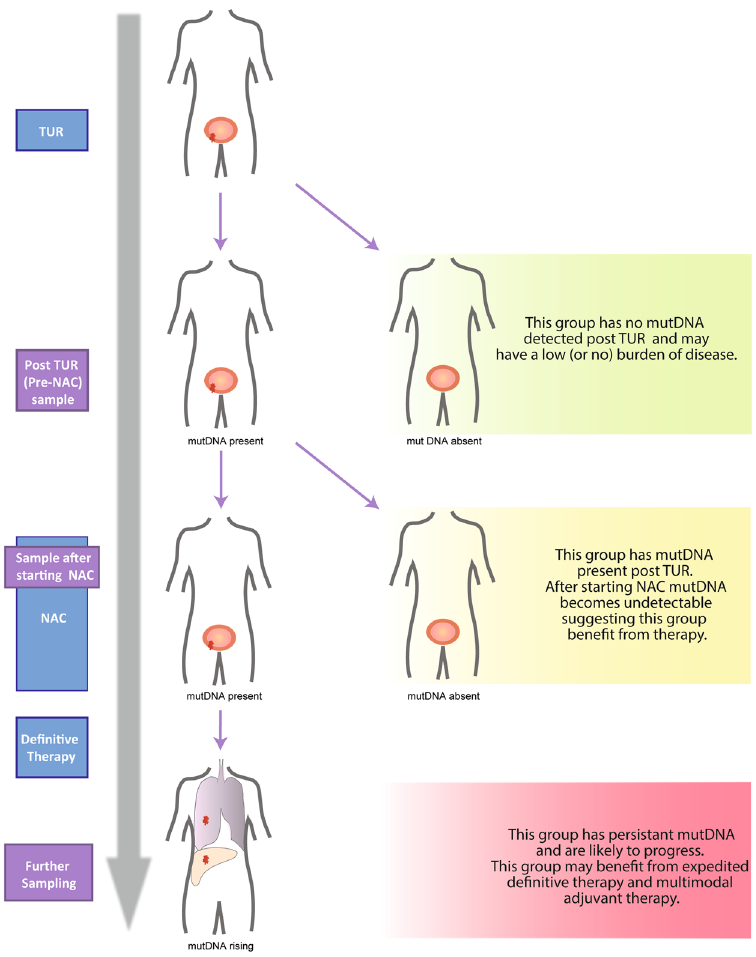
Figure 6. MutDNA analysis may help stratify patients with MIBC in the future. Based on our data, we have generated a model by which a patient’s outcome can be predicted by mutDNA status before and during NAC. Specifically, mutDNA status may be used to stratify patients into 3 groups. Firstly, patients with undetectable mutDNA pre-NAC and during NAC, have a low (or no) burden of disease (green). Secondly, patients with detected mutDNA pre-NAC but with negative samples at the 2 nd NAC cycle are likely to benefit from their NAC and subsequent definitive therapy (yellow). Finally, patients with mutDNA detected before and during NAC are unlikely to benefit from continued NAC and often progress (red). These patients should be considered for expedited definitive treatment or alternative treatments (e.g. targeted therapy or immune checkpoint